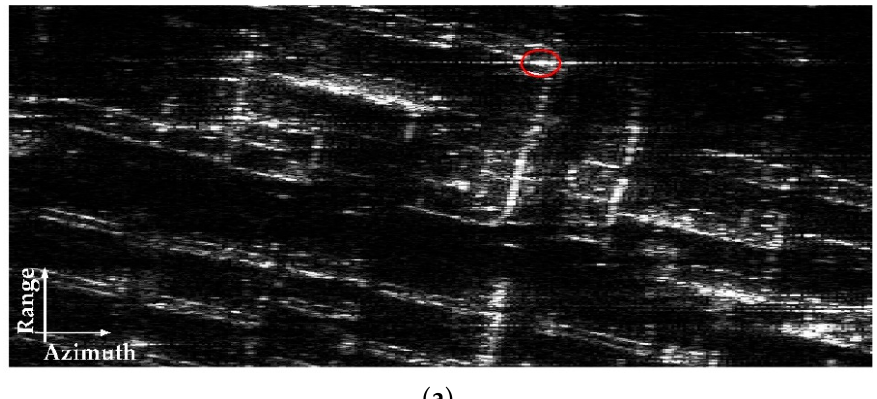
Figure 13. SAR images of traditional BP algorithm. ( a ) Result of original SAR data. ( b ) Result of downsampled SAR data.